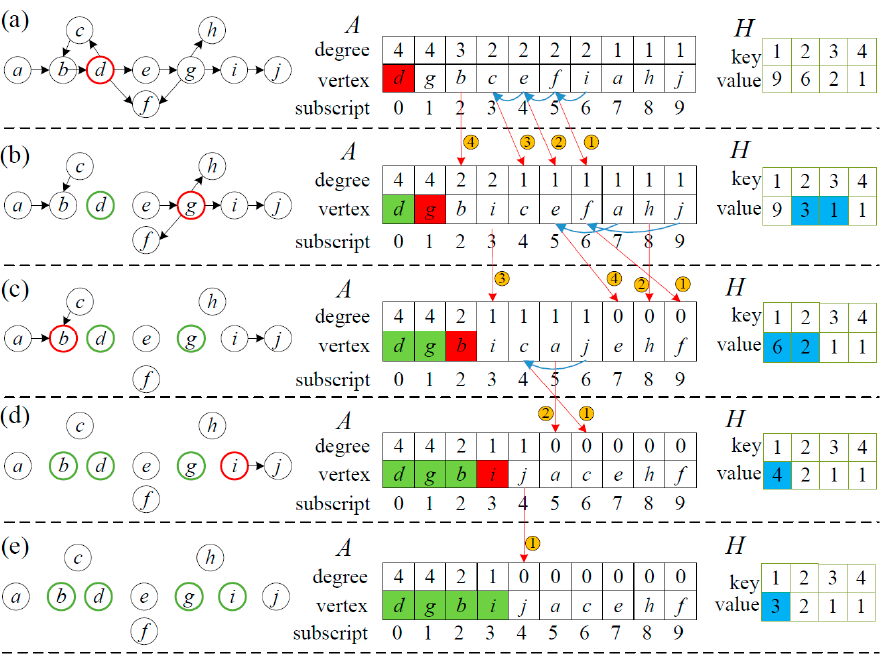
Figure 3. Running status of Algorithm 1, where ( a ) shows the initial status before processing any vertex and where ( b – e ) are the status after processing d , g , b , and i , respectively. In each subfigure, A is the array maintaining the vertices after sorting operation by degree, and H is the hash table.